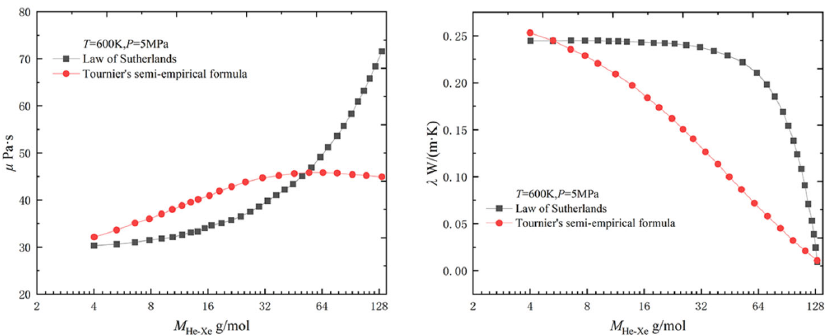
Figure 1. Comparison of Sutherland’s law and Tournier’s semi-empirical formulas for prediction of dynamic viscosity and thermal conductivity [14].